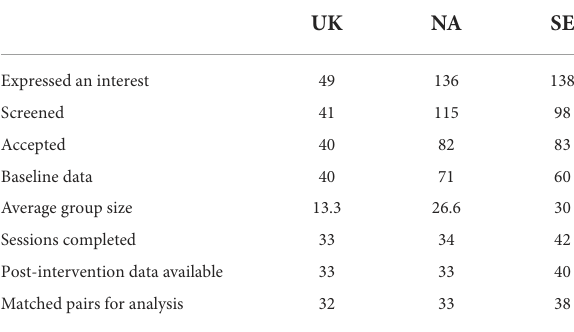
TABLE 1 Data recruitment and retention.